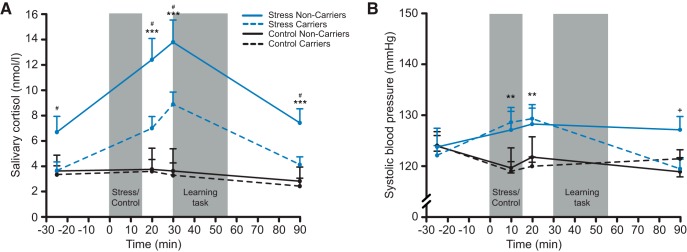
Physiological data of Experiment II. A, Salivary cortisol concentrations were increased in response to the TSST but were generally diminished in MR haplotype carriers. B, Similarly, stress exposure led to significant increases in systolic blood pressure and carriers of the MR haplotype show increased levels ∼75 min following the stressor. ***p < 0.001, **p < 0.01, *p < 0.05 indicate significant differences between stress and control group; #p < 0.05 indicates significant differences between MR haplotype carriers and no-carriers; +p < 0.05 indicates differences between MR haplotype carriers and no-carriers under stress, error bars represent SEM.